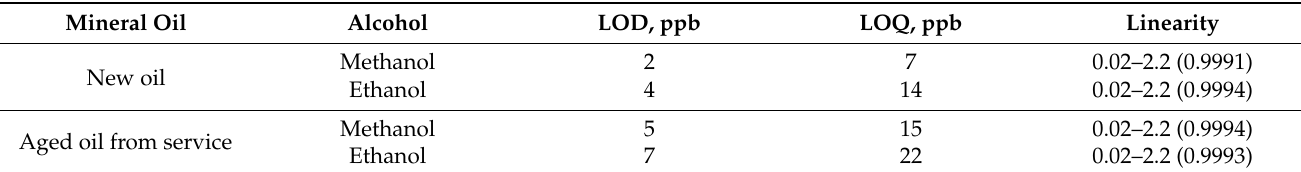
Table 2. LOD and LOQ of methanol and ethanol, TOGA GC FID